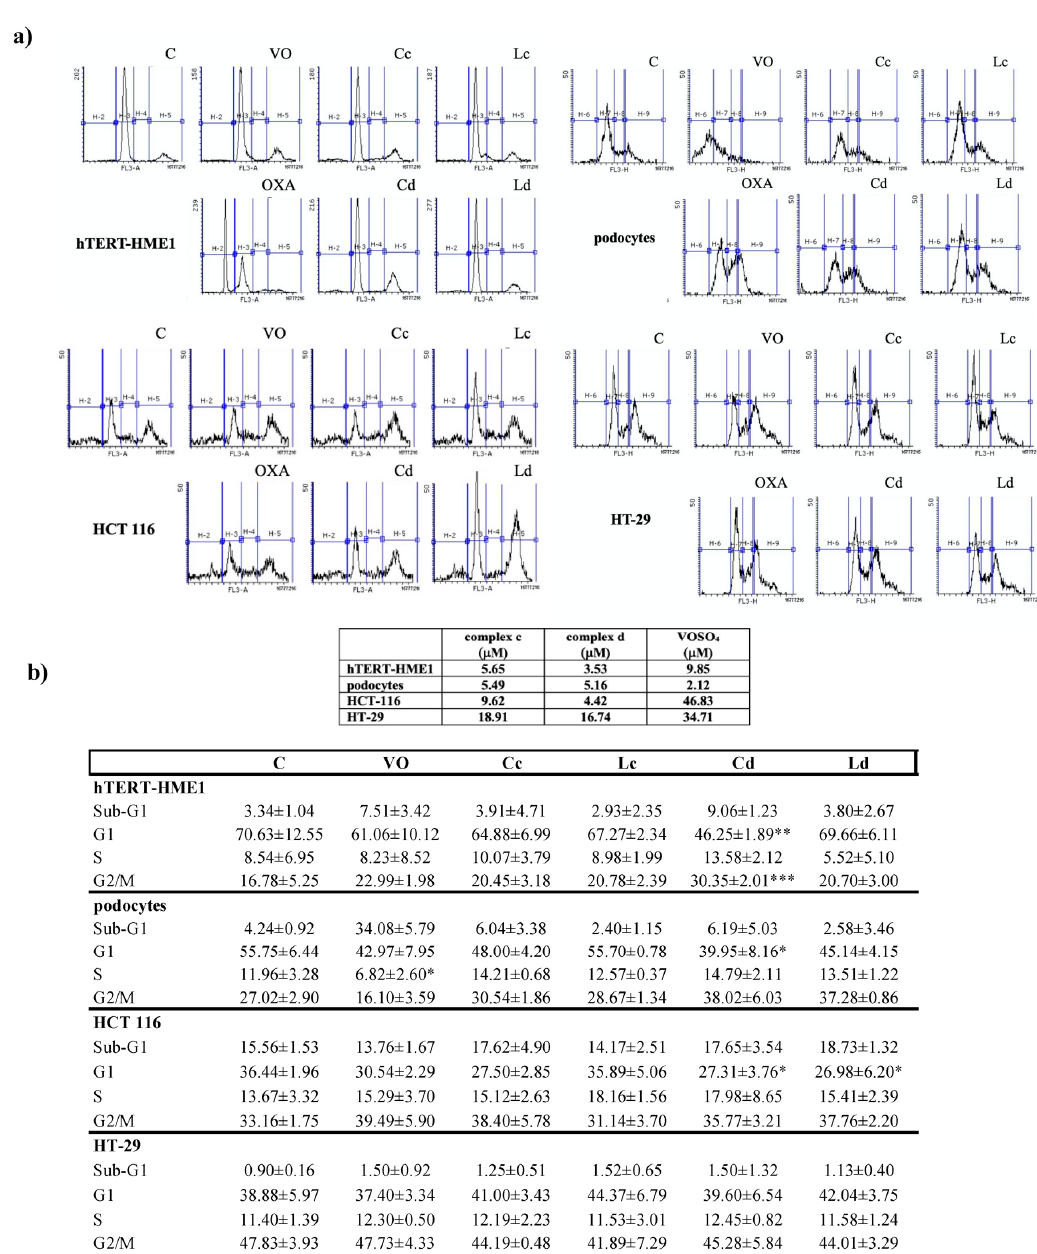
Figure 3. Effect of vanadyl complexes on cell cycle. Cells were treated for 24 h with complexes used at the IC 50 calculated from the antiproliferative assay and with ligands used at the same concentrations of the respective complex. VOSO 4 was used at the IC 50 , calculated from the previously conducted antiproliferative assays or at the maximum concentration if the 50% of proliferation inhibition was not reached. The concentrations utilized are in the table present in the figure. ( a ) The effect of complexes on cell cycle was analyzed by flow cytometry, using the flow cytometer BD AccuriTM C6 (Bd Biosciences, Erembodegem, Belgium) H-2: Sub-G1, H-3: G1, H-4: S, H-5: G2/M. ( b ) Percentage of means of at least 4 independent experiments are shown. Value are presented as the means ± S.D.; n = 3; * p < 0.05; ** p < 0.01; *** p < 0.001 vs. control (C). VO: VOSO 4 , Cc: complex c, Cd: complex d, Lc: ligand c, Ld: ligand